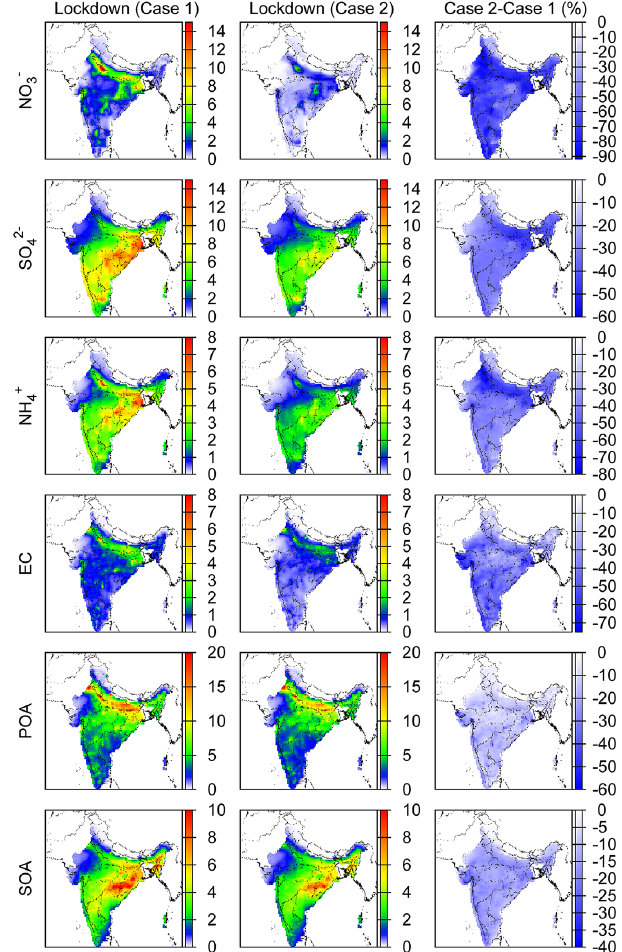
Figure 5. Predicted PM 2 . 5 components and the changes caused by lockdown measures from 24 March to 24 April 2020 in India. The unit is µgm − 3 . “Case 2 − Case 1” indicates (Case 2 − Case 1) / Case 1, reported as